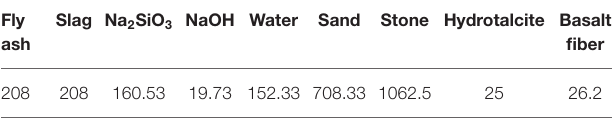
TABLE 1 | Mix proportion of BFRAAC (kg for 1 m 3 of BFRAAC). Fly